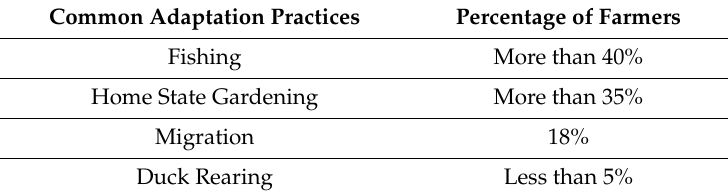
Table 5. Common adaptation practices implemented by farmers by percentage.